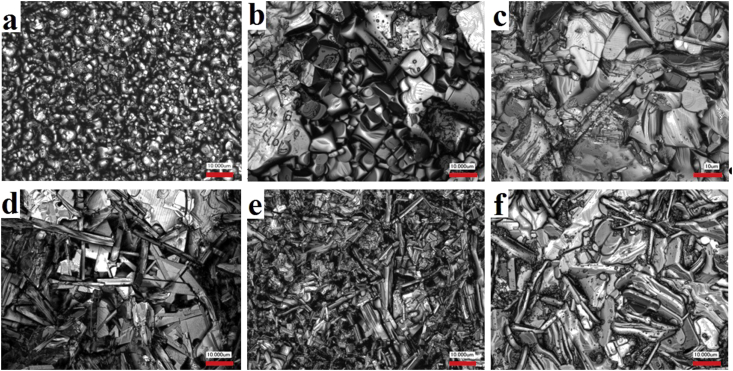
Fragments of the microstructure of the NCN solid solutions (a: x = 0, b: x = 0.175, c: x = 0.25, d: x = 0.3, e: x = 0.55, f: x = 1).